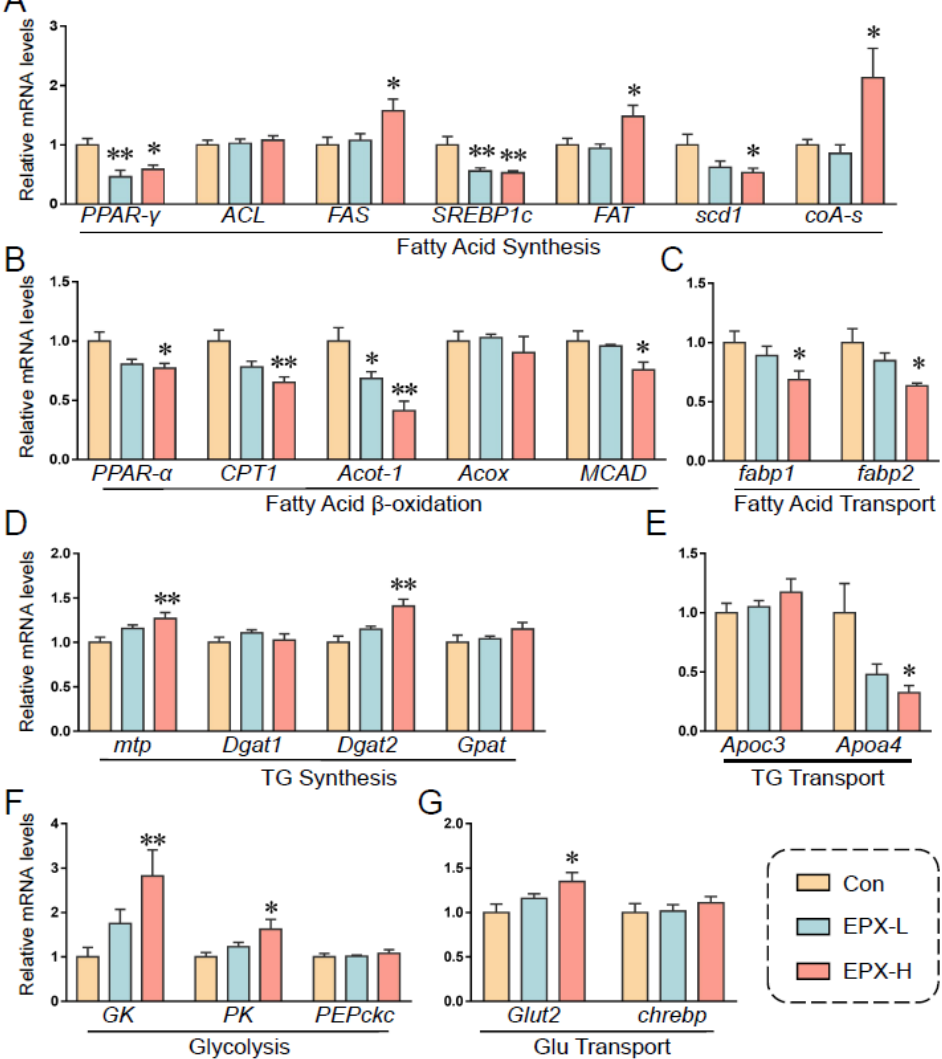
Figure 6. Effects of the oral exposure to EPX on the transcriptional levels of genes related to glycolipid metabolism. ( A ) Fatty acid synthesis. ( B ) Fatty acid β -oxidation. ( C ) Fatty acid transport. ( D ) TG synthesis. ( E ), TG transport. ( F ) Glycolysis. ( G ) Glu transport. Values are shown as the means ± SEM ( n = 8), and statistical significance: p < 0.05 *; p < 0.01 **.